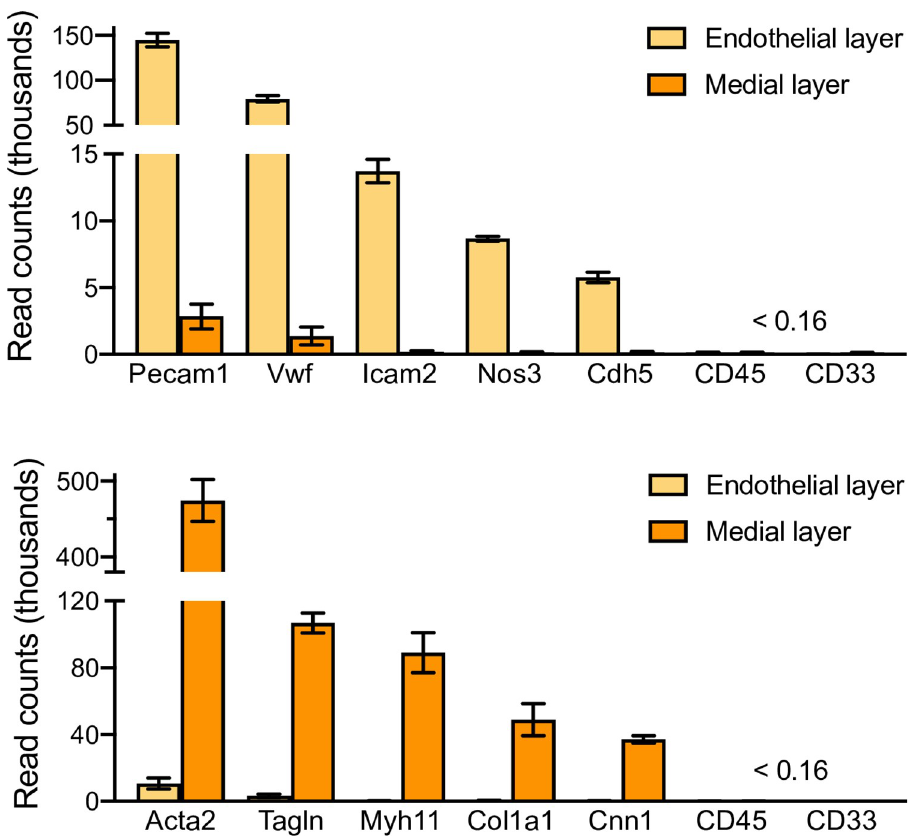
Fig 8. Validation of sample preparation in RNA-seq experiment. RNA was purified from mouse carotid arteries after separation of endothelial and medial layers. The bar graphs represent mRNA expression as average ± SEM of read counts from 4 Poldip2 -/- mice. Similar results were obtained from control mice. Successful separation of vascular layers is indicated by the enrichment in gene markers specific for endothelium (top) and smooth muscle (bottom). Sample contamination by blood was negligible, as shown by the minimal expression of leukocyte markers (CD45 and CD33). Endothelial markers: Pecam1 (platelet endothelial cell adhesion molecule 1), Vwf (Von Willebrand factor), Icam2 (intercellular adhesion molecule 2), Nos3 (nitric oxide synthase 3), Cdh5 (cadherin 5). Smooth muscle markers: Acta2 (smooth muscle alpha actin 2), Tagln (transgelin), Myh11 (smooth muscle myosin heavy chain), Col1a1 (collagen type I alpha 1), Cnn1 (calponin